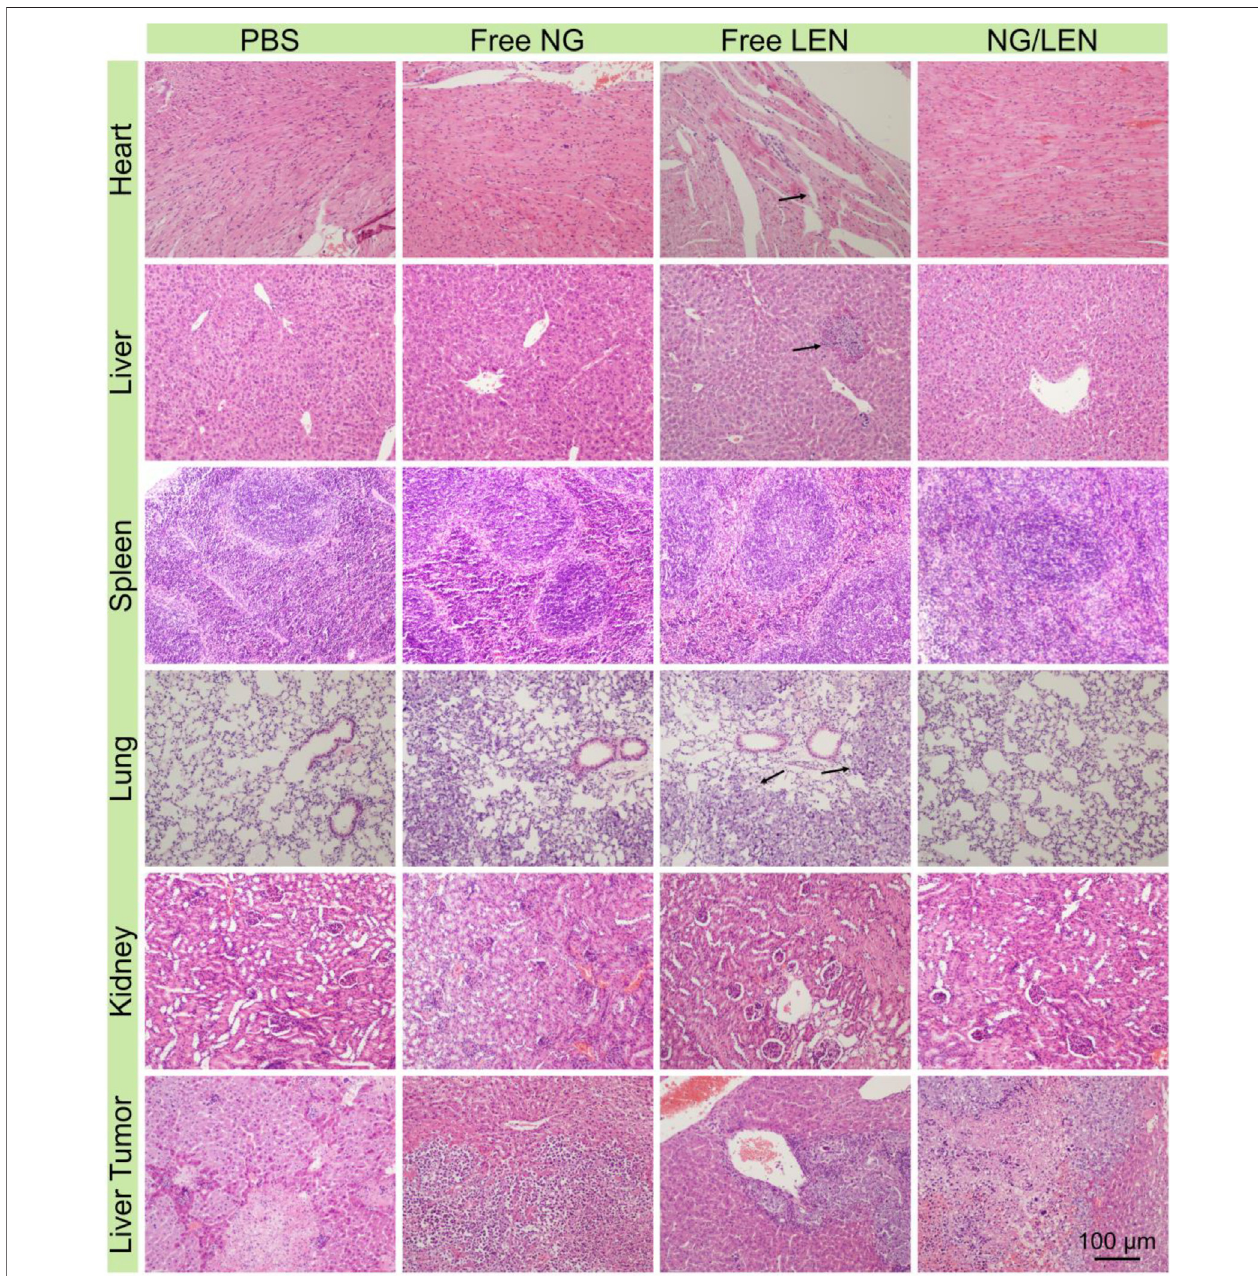
FIGURE 8 | Histopathological analysis of organ sections, i.e. , heart, liver, spleen, lung, kidney, and liver tumor after treatment with PBS, free NG, free LEN, or NG/ LEN toward orthotopic HCC model of BALB/c mice. Arrows indicate the injury parts.